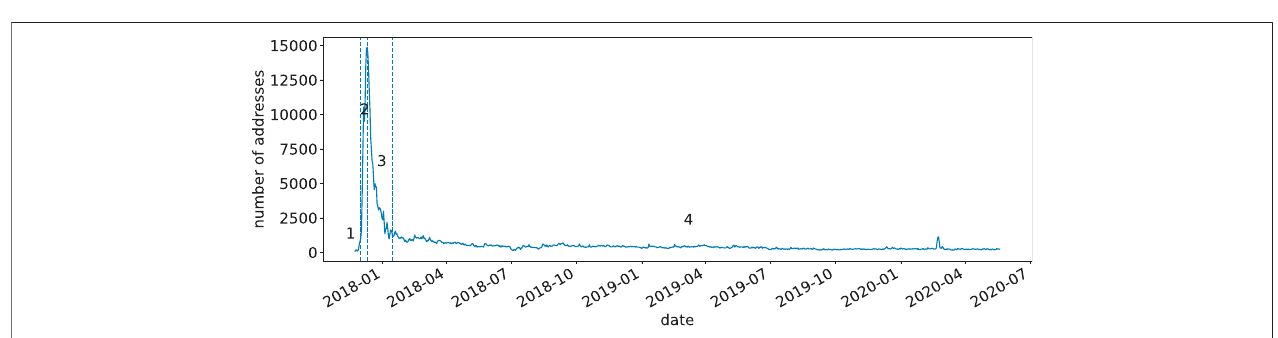
FIGURE 2 | Four stages of the game. The three dotted lines correspond to December 1, 2017, December 10, 2017, and January 15, 2018, respectively.